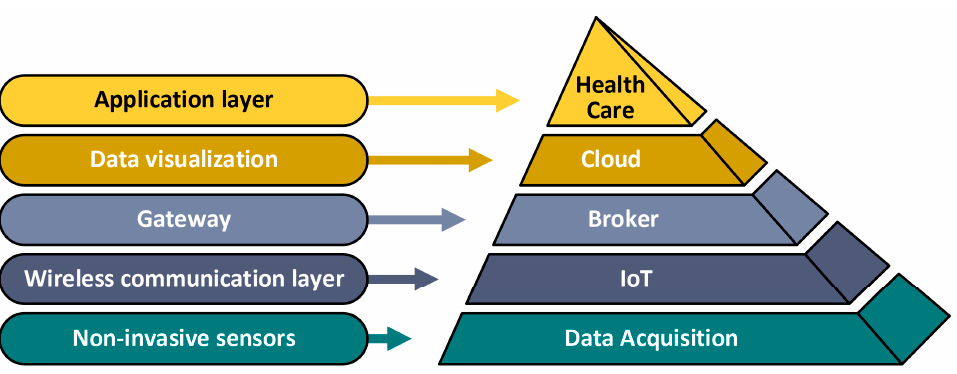
Figure 2. Hierarchy of healthcare solutions.